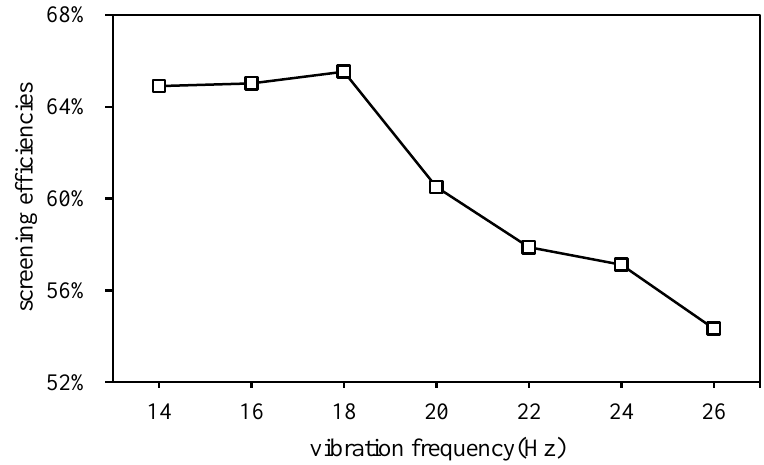
Figure 11. Screening e ffi ciencies of a cantilevered vibrating sieve (CVS) for di ff erent vibration frequency.